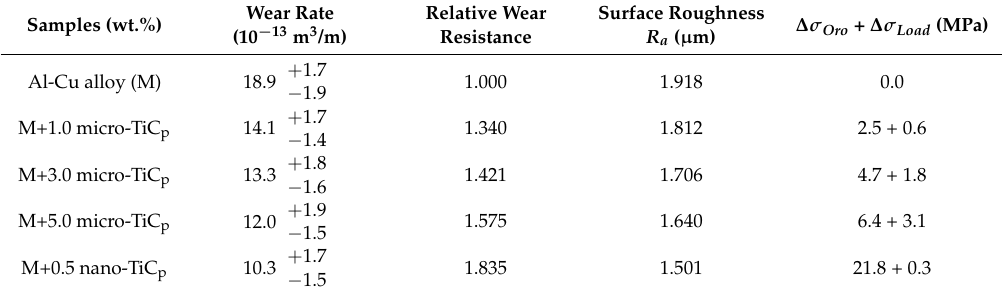
Table 1. The high-temperature wear properties and the theoretical values of Δ σ Oro and Δ σ Load at 180 °C of the Al-Cu alloy and TiC p /Al-Cu composites with different sizes and contents of TiC p .